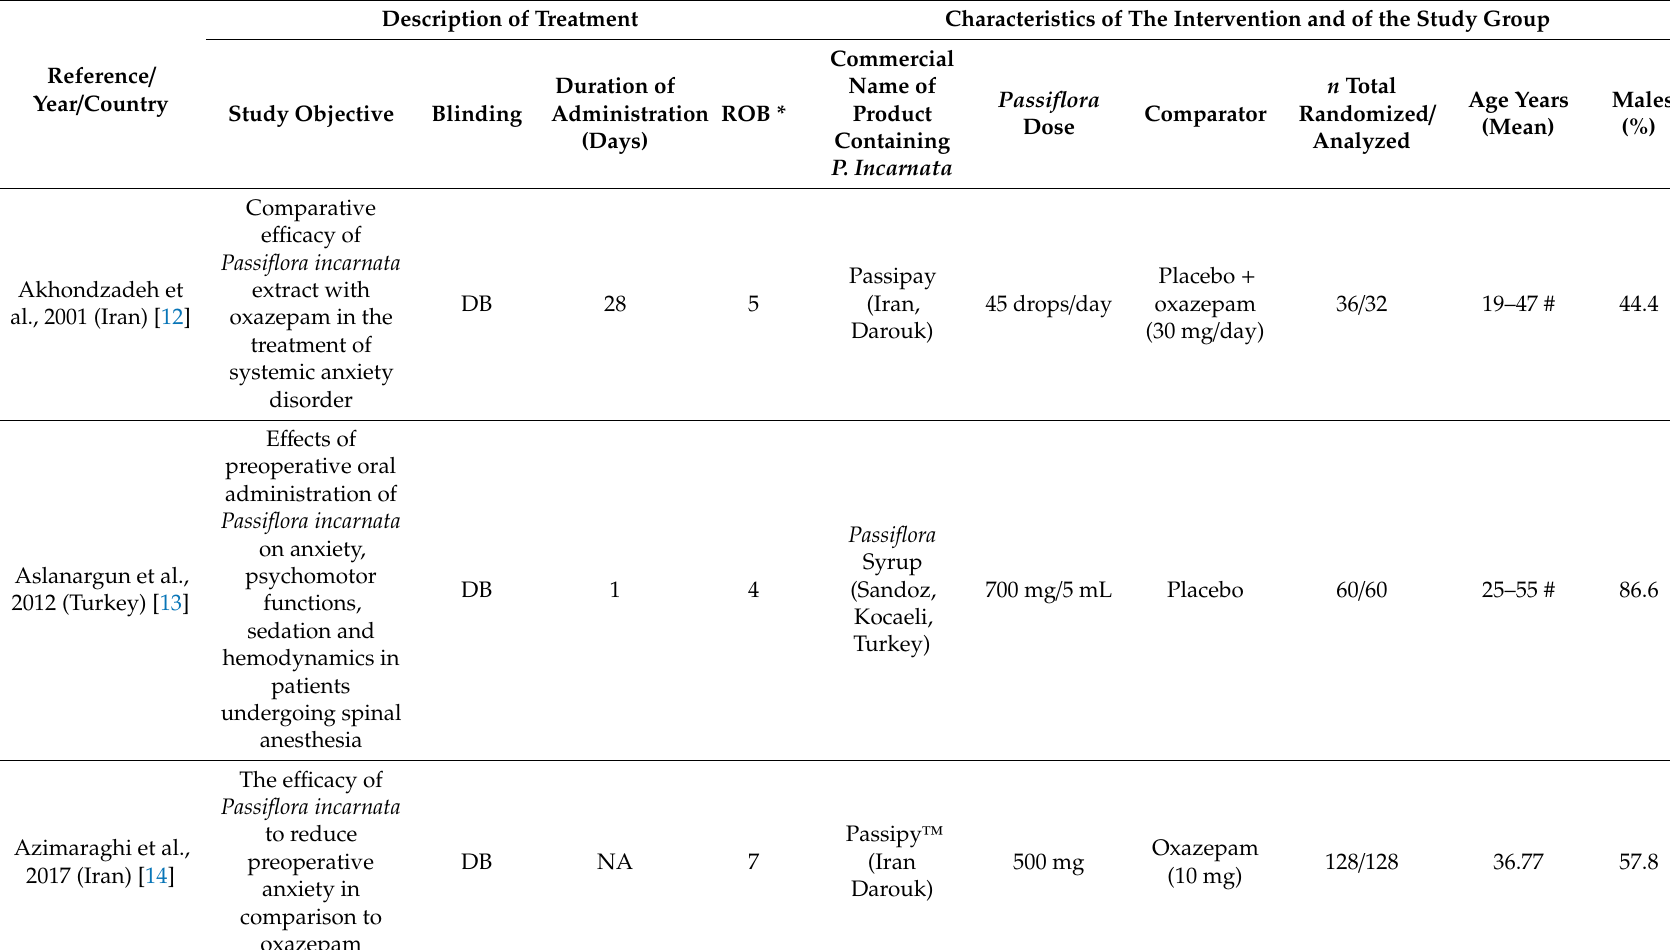
Table 1. Characteristics of studies included in the systematic